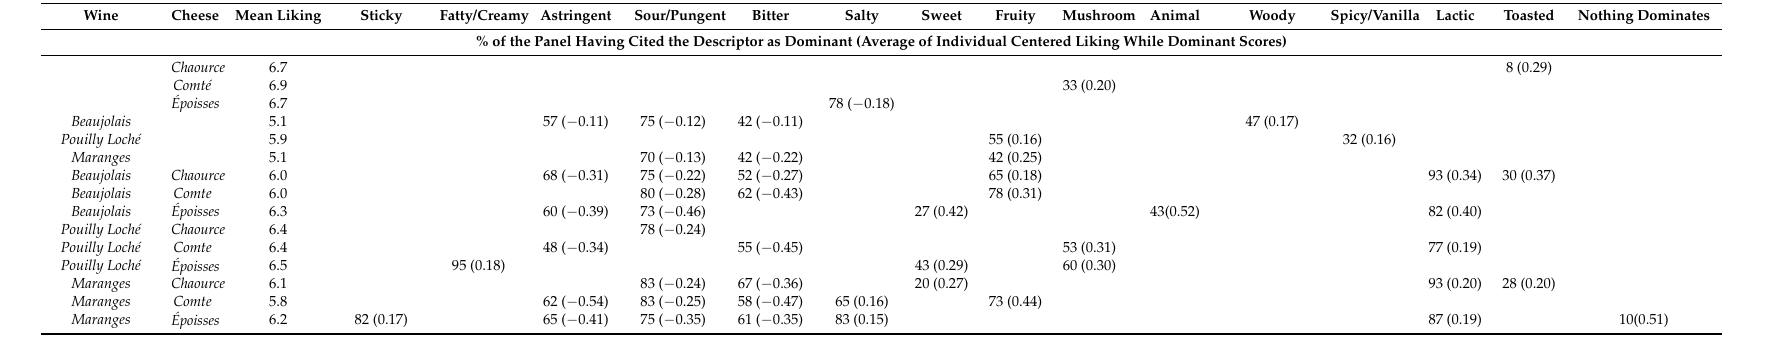
Table 6. Mean liking scores and temporal drivers of liking for cheeses, wines and